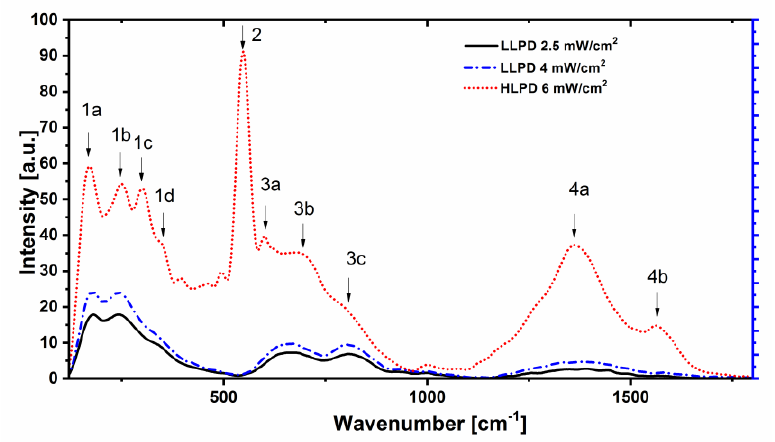
Figure 4. Raman spectra of the sample 1 recorded in three different laser-annealing regimes: LLPD at 2.5 mW/cm 2 , LLPD at 4 mW/cm 2 , and HLPD at 6 mW/cm 2